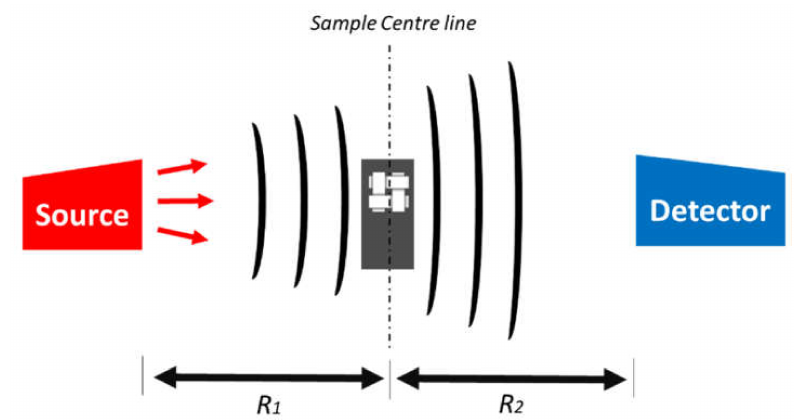
Figure 4. Source, sample, and detector arrangement and spacing during Micro-CT imaging.